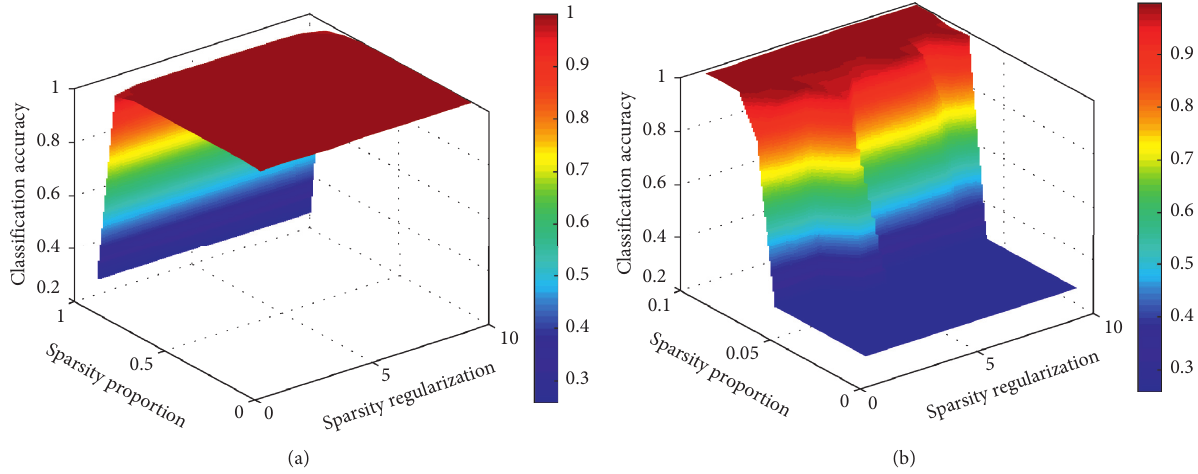
Figure 13: The relationship of classification accuracy and parameters for testing samples of worm gear dataset: (a) sparsity proportion term in [0.1, 1] and the sparsity regularization term [1, 10]; (b) sparsity proportion term in [0.01, 0. 1]; the sparsity regularization term [1,